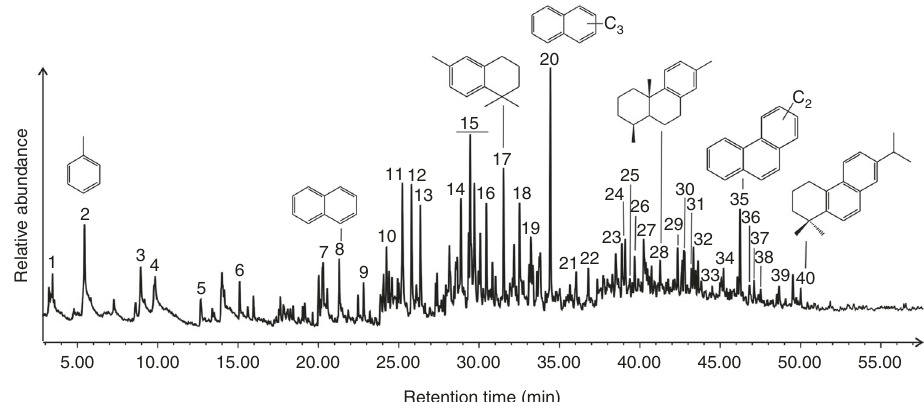
Fig. 4 Total ion chromatogram of Tilin amber from Py-GC-MS analysis. Identi fi cation of numbered peaks is listed in Supplementary